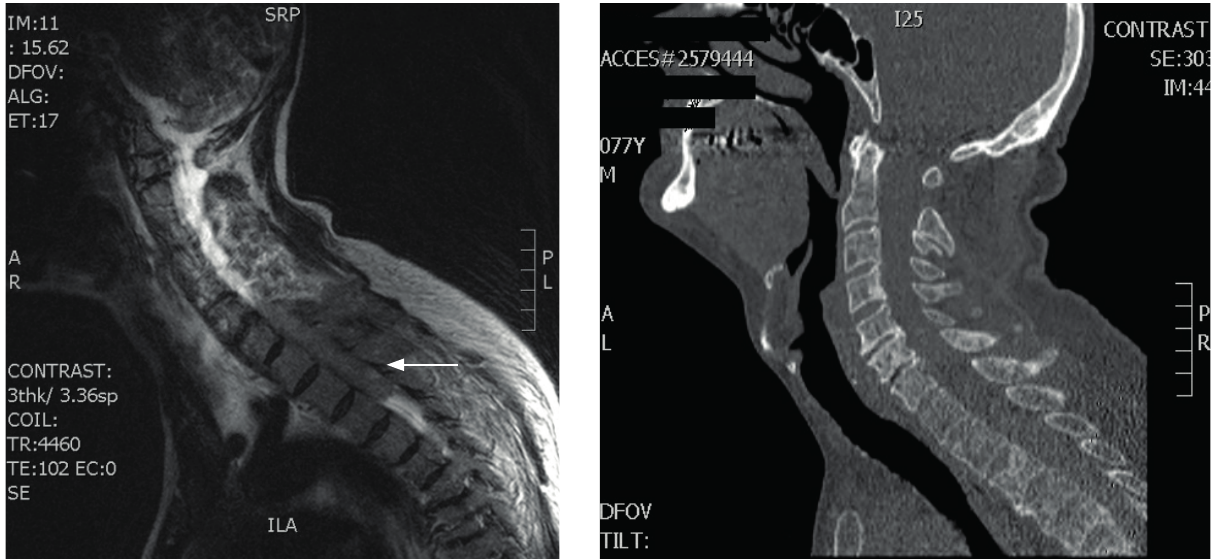
Fig. 2. Extramedullary lesion in the spinal column of a patient with multiple myeloma – comparison of low-dose computed to- mography and magnetic resonance imaging. Magnetic resonance imaging (left) showing in the STIR sequece a large extramedullary lesion (white arrow) in the spinal column of a patient with multiple myeloma. Low-dose computed tomography (right) of the same region showed more osteolytic lesions of vertebrae, however, it did not show the extramedullary lesion as it did not disrupt the cortical